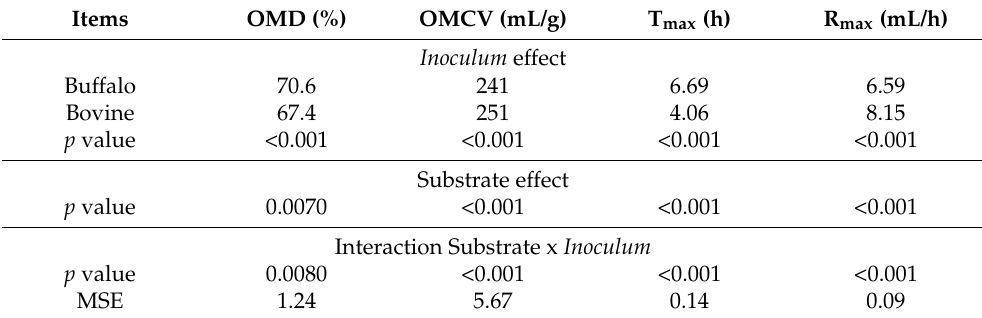
Table 5. Least square means for in vitro fermentation parameters after 120 h of incubation.